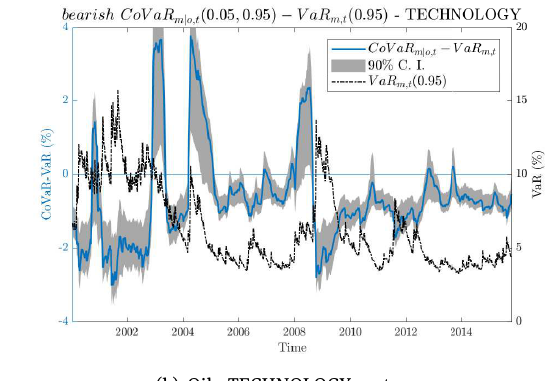
(k) Oil - TECHNOLOGY sector Left axis shows the difference in percentage between the CoVaR (0.05, 0.95) of the returns for a certain sector under a m , t extreme downward movement in oil prices, i.e. below its 5-th quantile, and its unconditional VaR (0.95). Solid blue line m , t shows this difference given the best copula mixture according to Table 6. Grey area indicates the 90% confidence interval of the difference between CoVaR (0.05, 0.95) and VaR (0.95) following a Monte Carlo technique explained in Appendix C. The m , t m | o , t right axes shows the value of the VaR (0.95) in percentage. The dash-dotted black line indicate the VaR level over m , t